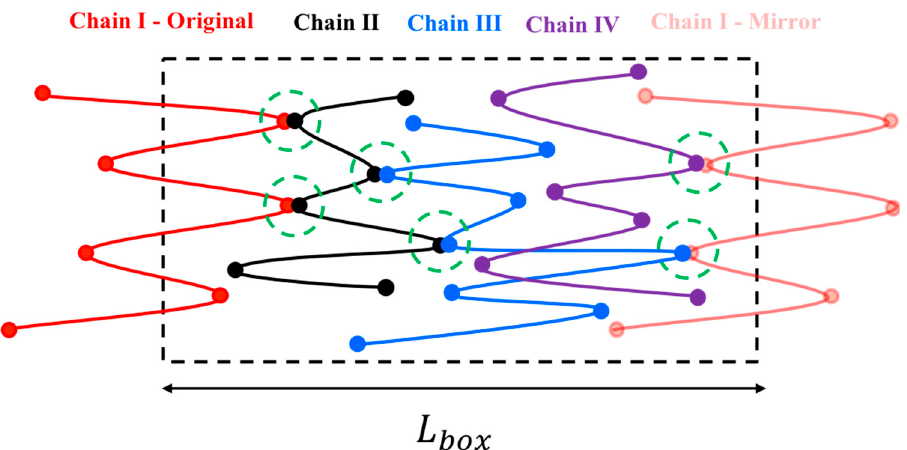
Figure 2. Periodic boundary condition applied at the simulation box limits. Mirror image of chain I (pale red) is entangled with chains III and IV shown in blue and purple, respectively. The original image of chain I is also entangled with chain II inside the simulation box. The schematic is adapted from our previous publication [18] with permission, copyright American Chemical Society, 2019.